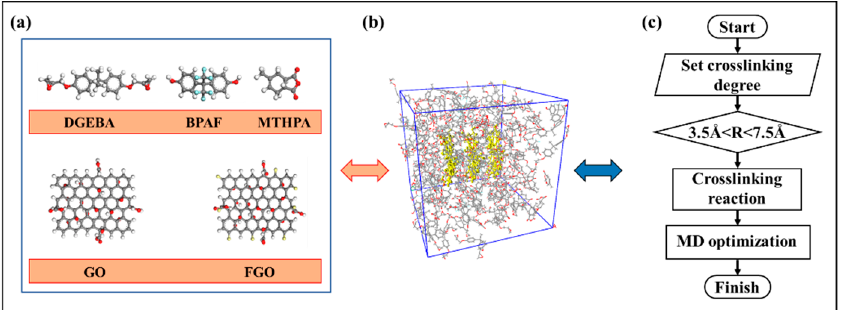
Table 1. Composition of FGO modified F ‐ EP Composites.